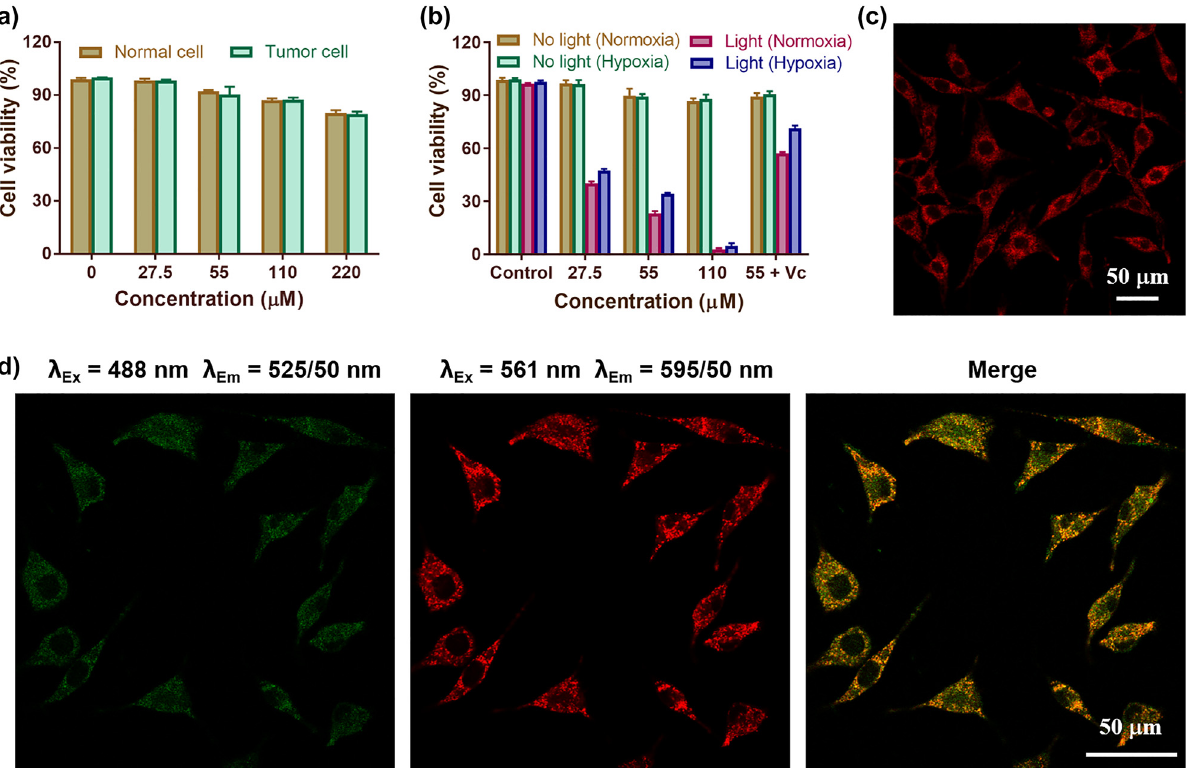
Figure 2: Cytotoxicity of SQ NPs on SH-SY5Y cells and their intracellular localization. (a) Dark toxicity of SQ NPs in normal cells (HEK29) and tumor cells (SH-SY5Y). The relative viabilities of SH-SY5Y cells incubated with different concentrations of SQ NPs for 12 h. (b) Phototoxicity of SQ NPs on SH-SY5Y cells with various treatments. (c) The intracellular imaging of SQ NPs. (d) Confocal laser scanning microscope of SHSY-5Y cells co-stained with SQ NPs and LysoTracker TM